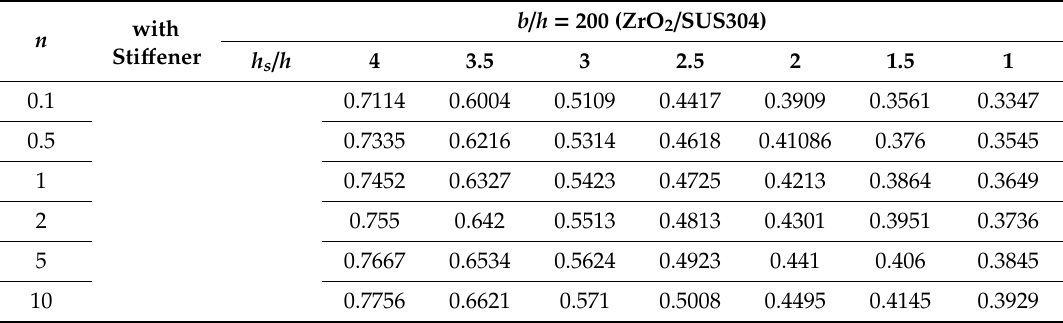
Table 15. Buckling coe ffi cient of FGM plate with and without a central sti ff ener (ZrO 2 / SUS304, b / h = 200).